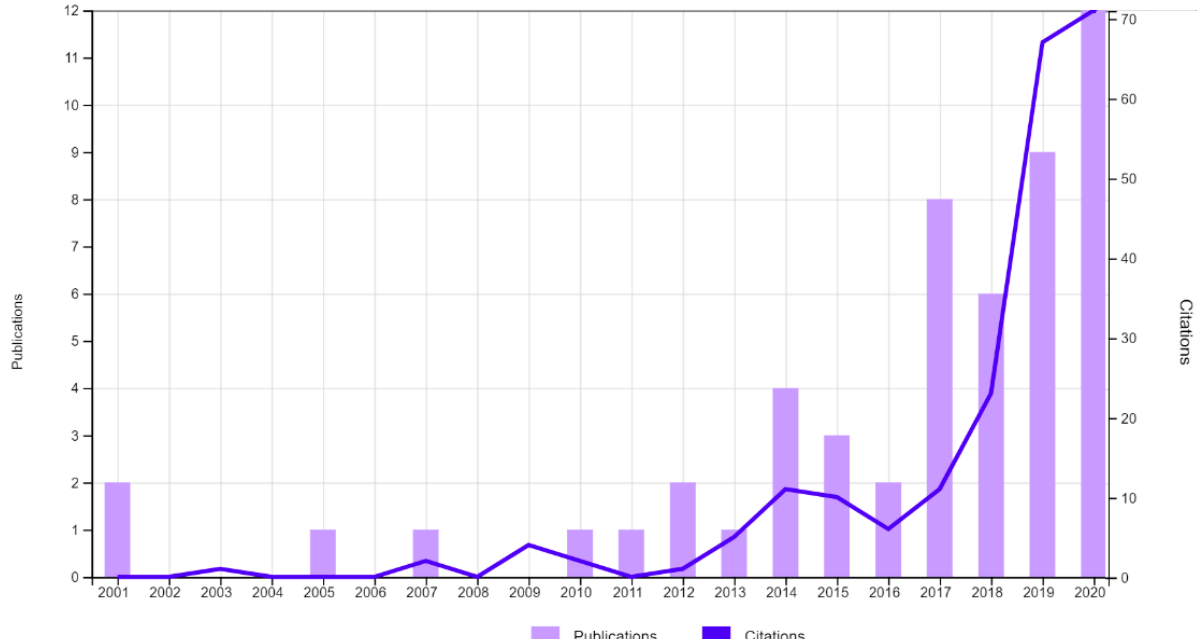
Figure 2. Publications (and their citation rate) included in Web of Science database relating to tax and robotics research in 2000–2020.